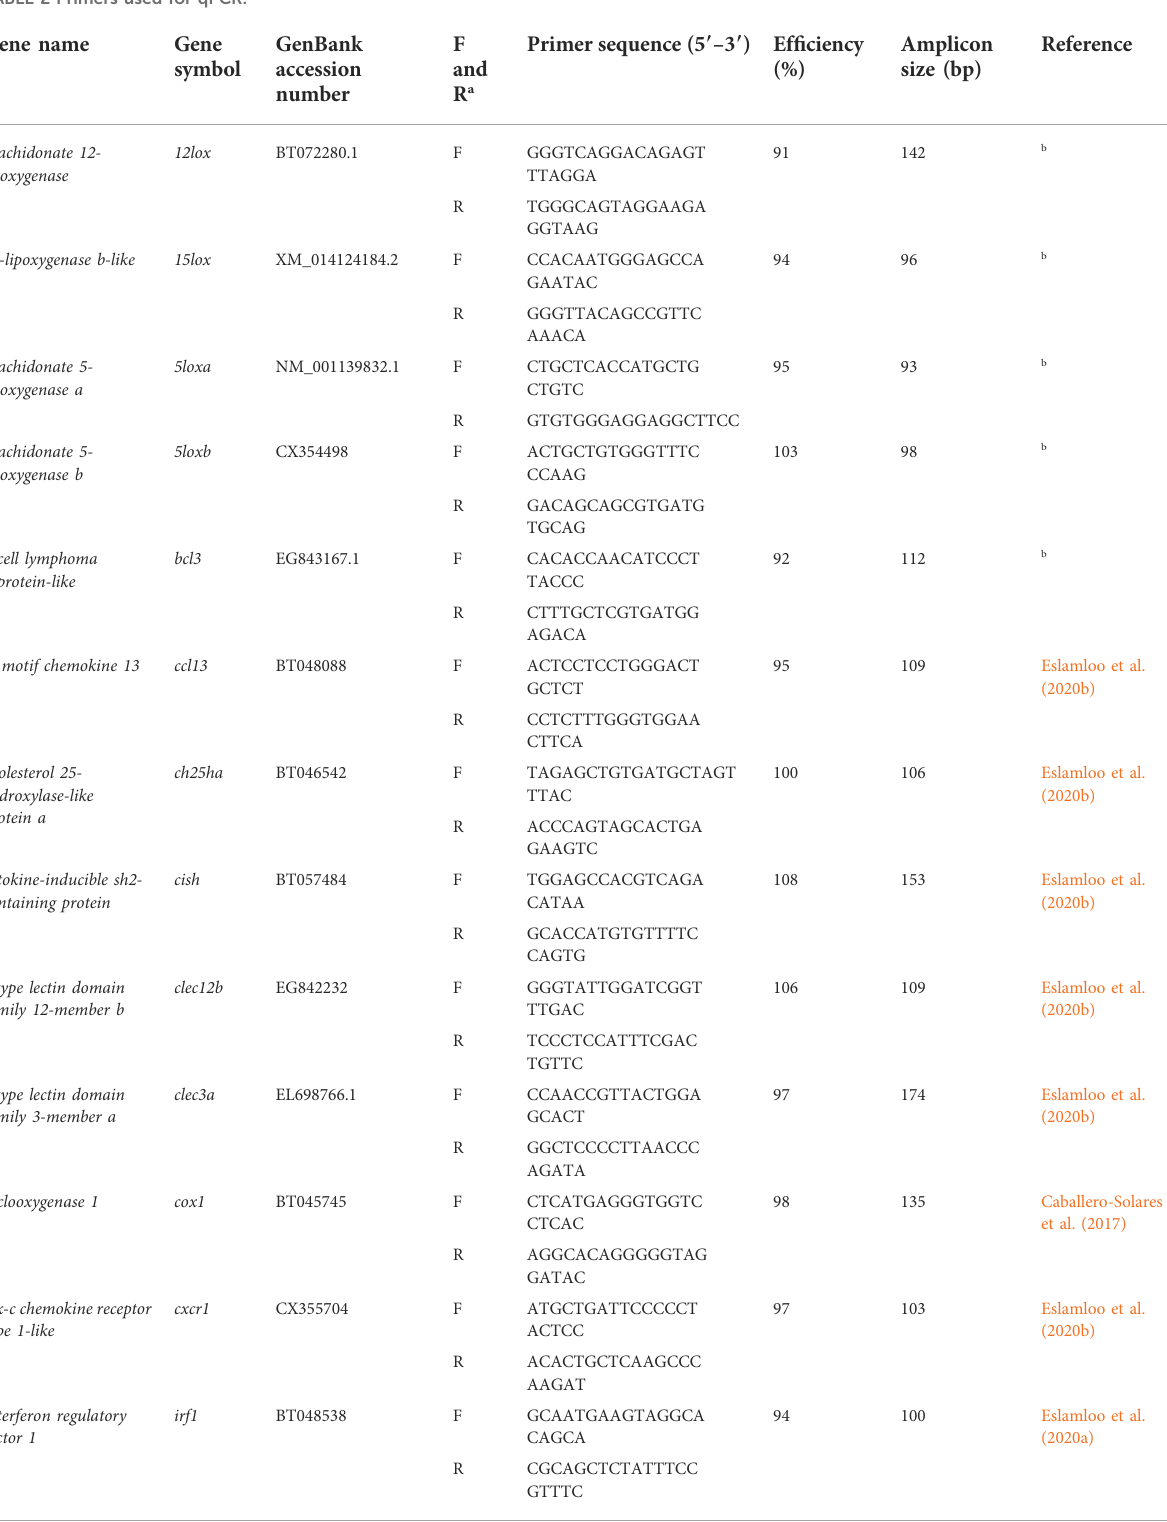
TABLE 2 Primers used for